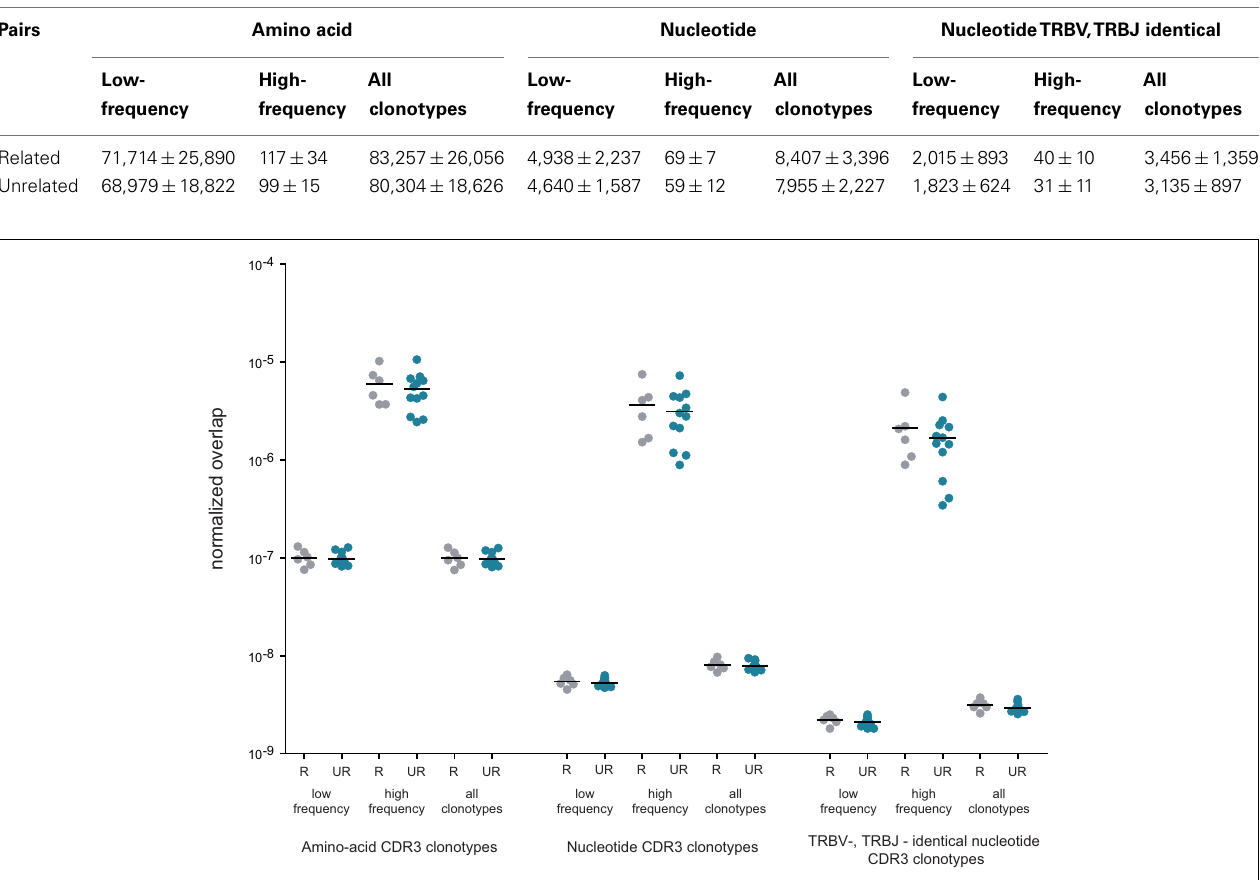
Table 2 |Average number of sharedTCR beta CDR3 clonotypes in related and unrelated pairs .